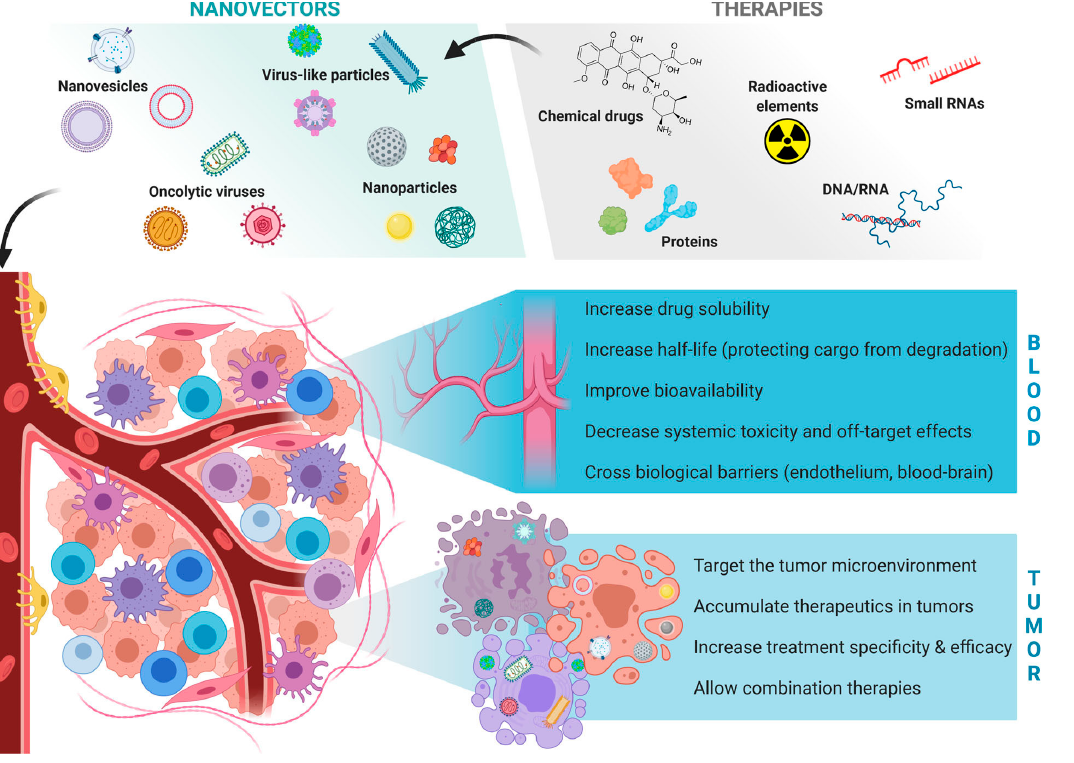
Figure 1. The advantages of applying nanocarriers for delivering cancer therapies [11].